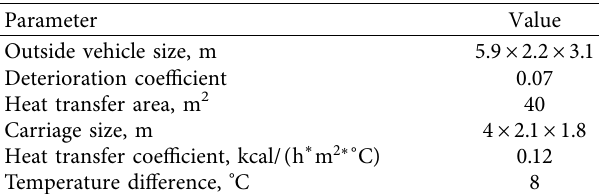
Table 5: Vehicle parameter